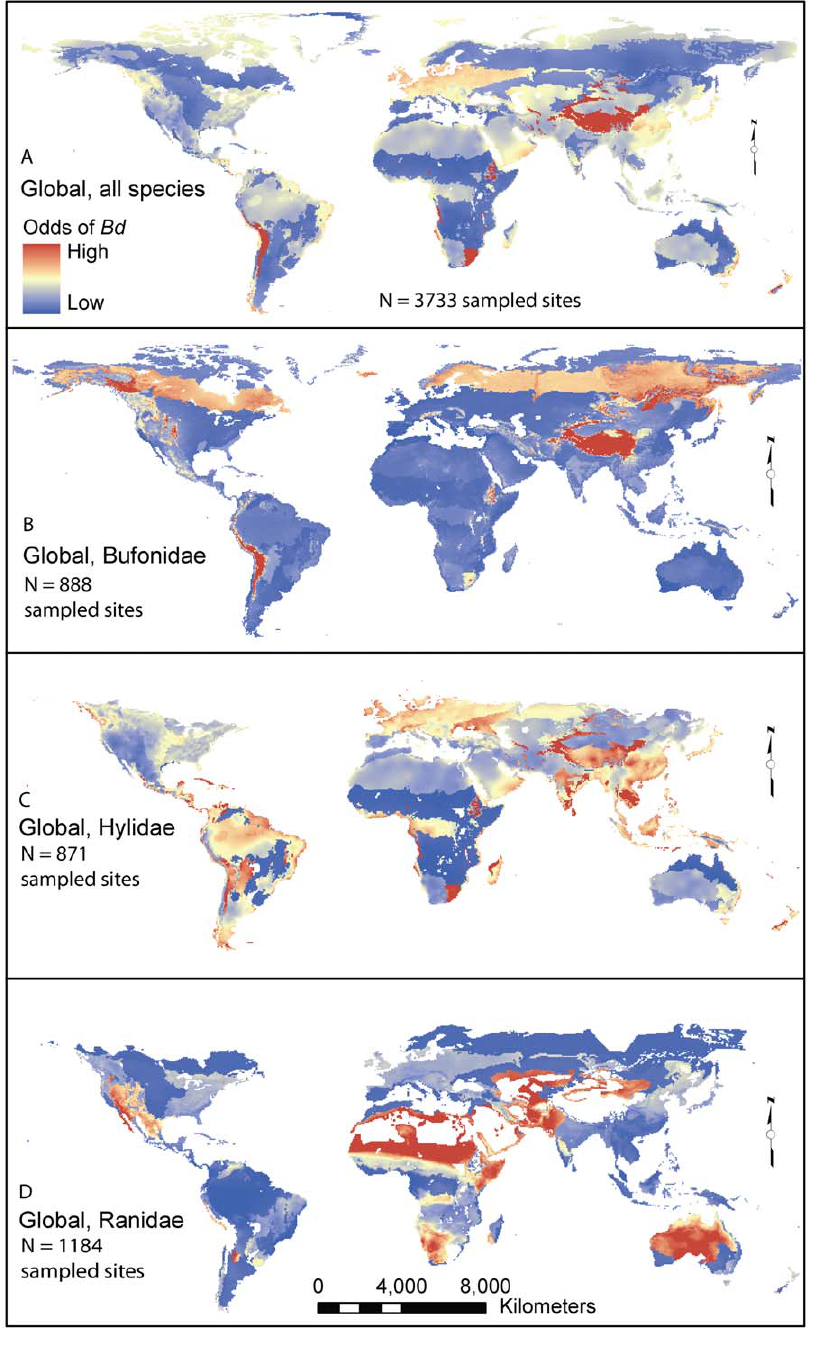
Figure 4. Extrapolated global maps of the odds of Batrachochytriumdendrobatidis ( Bd ) detection in amphibians derived from regression models. The global model using data from all species combined is shown (A), as well as subsets of the world data for species within the amphibian families Bufonidae (B), Hylidae (C), and Ranidae (D). Although these map projections depict the odds of Bd detection at the world scale, it should be noted that amphibians do not occur everywhere in the world, and in particular, the three amphibian families (B,C,D) are not native to all regions world-wide. Significant model parameters differed among models and included landscape-scale site attributes including climate metrics and biotic factors, such as biome or amphibian species richness (see text). Gaps in the mapped models are due to a lack of species richness data, or amphibian absence, for certain regions. doi:10.1371/journal.pone.0056802.g004 chytridiomycosis. A caveat here is that such broad-brush analyses are all likely key to determining the local outcome of infection [46]. inevitably miss fine-scale relationships between amphibians, their microhabitats, and the little-understood relationship between Our finding of increased occurrence of Bd with species richness temperature and the ectothermic immune-response: these factors supports the hypothesis that greater complexity of amphibian